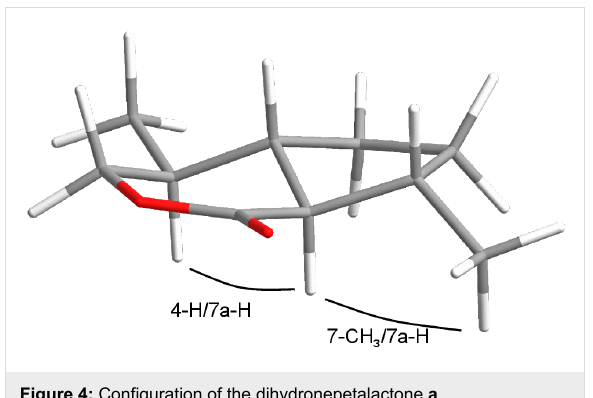
Figure 4: Configuration of the dihydronepetalactone a